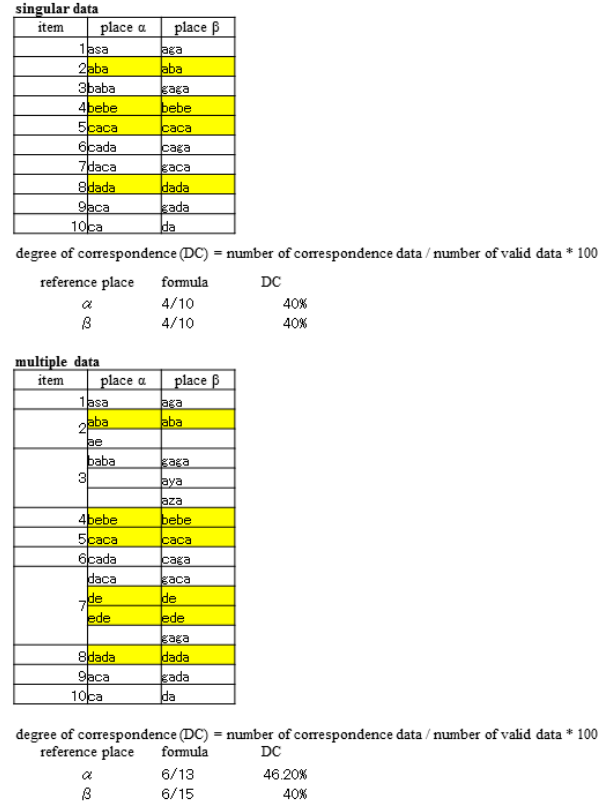
Figure 1. Examples of singular and multiple data (correspondence data are marked with yellow).